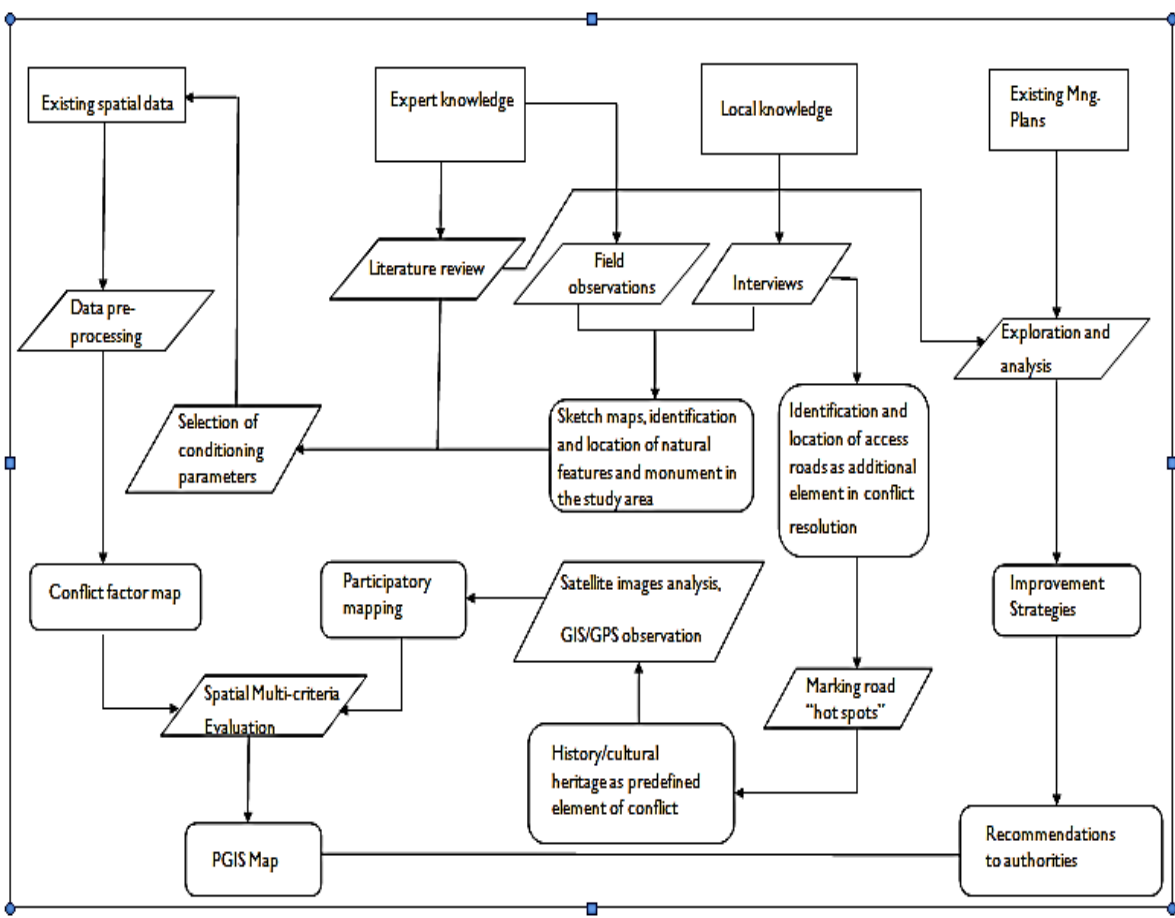
Figure 1. Process for developing a PGIS based framework for land conflict